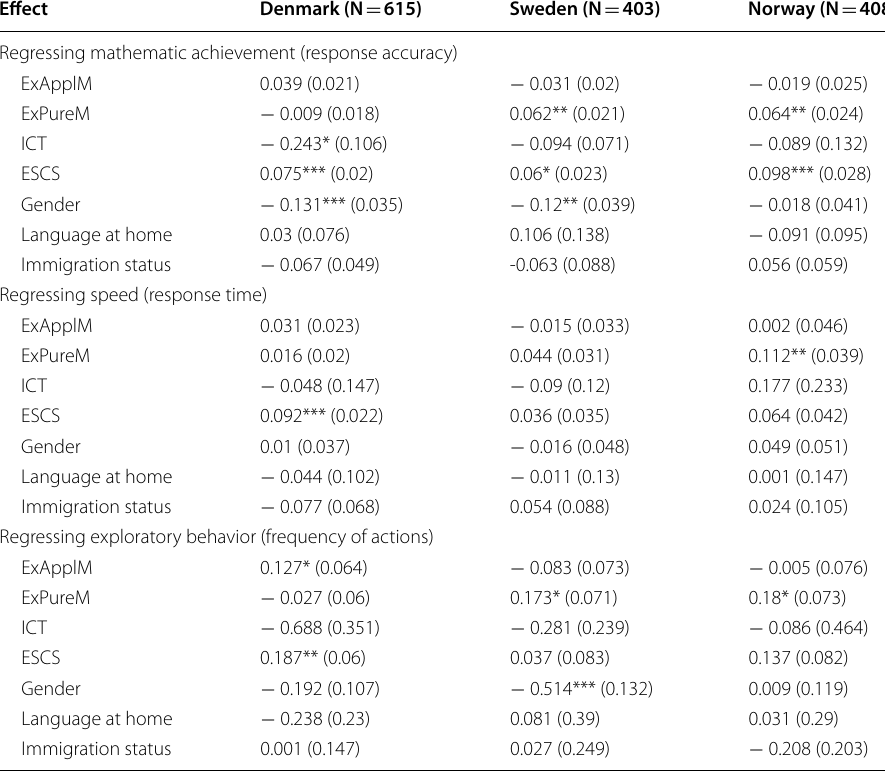
Table 10 Coefficients of ICT, OTL, and controlling variables on latent factors measured by response accuracy, response time, and frequency of